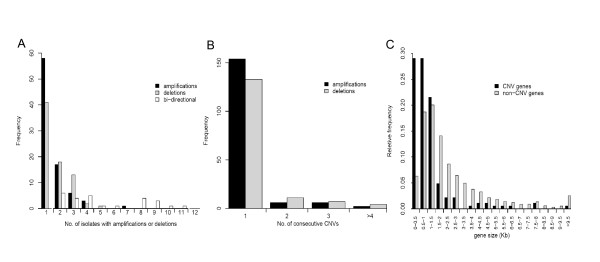
Features of CNV dataset. (A) 99 CNV genes (58 amplifications, 41 deletions) were detected in a single isolate whereas 87 were replicated between isolates and classed as common CNVs. (B) Consecutively detected CNV genes are infrequent for both amplifications (black bars) and deletions (white bars), the vast majority being non-adjacent to variable regions, the few large variants that we detected have been previously described and include sub-telomeric truncations in chromosomes 2 and 9 and amplification of the pfmdr1 gene locus on chromosome 5. Within consecutive CNV regions it was rare to find hybridisation signals uniformly outside of the cut-offs. Genes that precluded detection using this stringent cut-off though showed clear patterns of variation were identified as those adjacent to identified CNV genes and possessed a log2 ratio of +/- 0.8. (C) Length of CNV genes was shown to be a highly significant property of CNV genes being smaller than non-CNV genes.